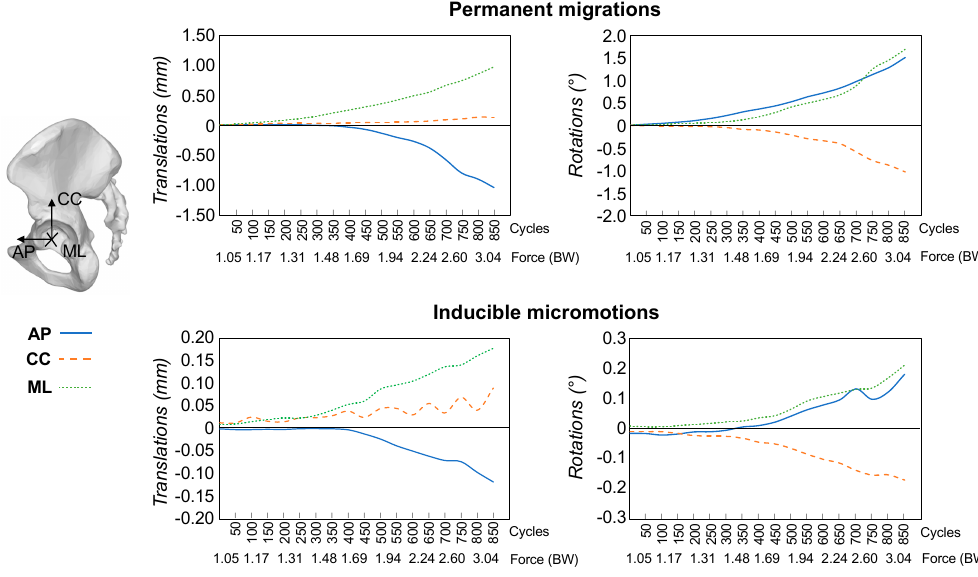
Figure 5. CaP-putty: The permanent migrations and inducible micromotions throughout the test are presented as the median trend of the specimens ( n = 5 hemipelvises). For the translations, the components along the antero-posterior (AP), cranio-caudal (CC) and medio-lateral (ML) directions are reported. The rotations are reported in terms of individual components about the antero-posterior (AP), cranio-caudal (CC) and medio-lateral (ML) axis. On the x -axis the load cycles (in packages of 50 cycles) and the corresponding magnitude of the applied force are indicated. Motions during the preconditioning load package are not presented.